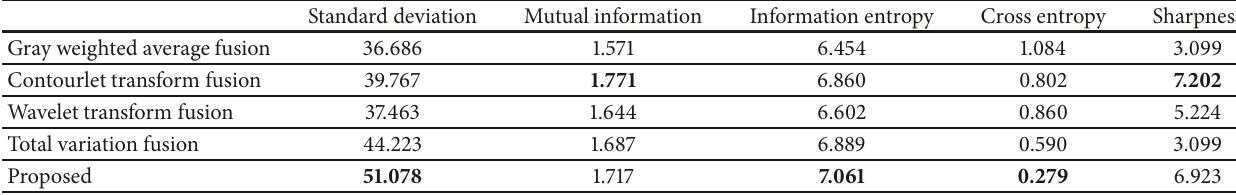
Table 4: Average evaluation value of different fusion methods at daytime.